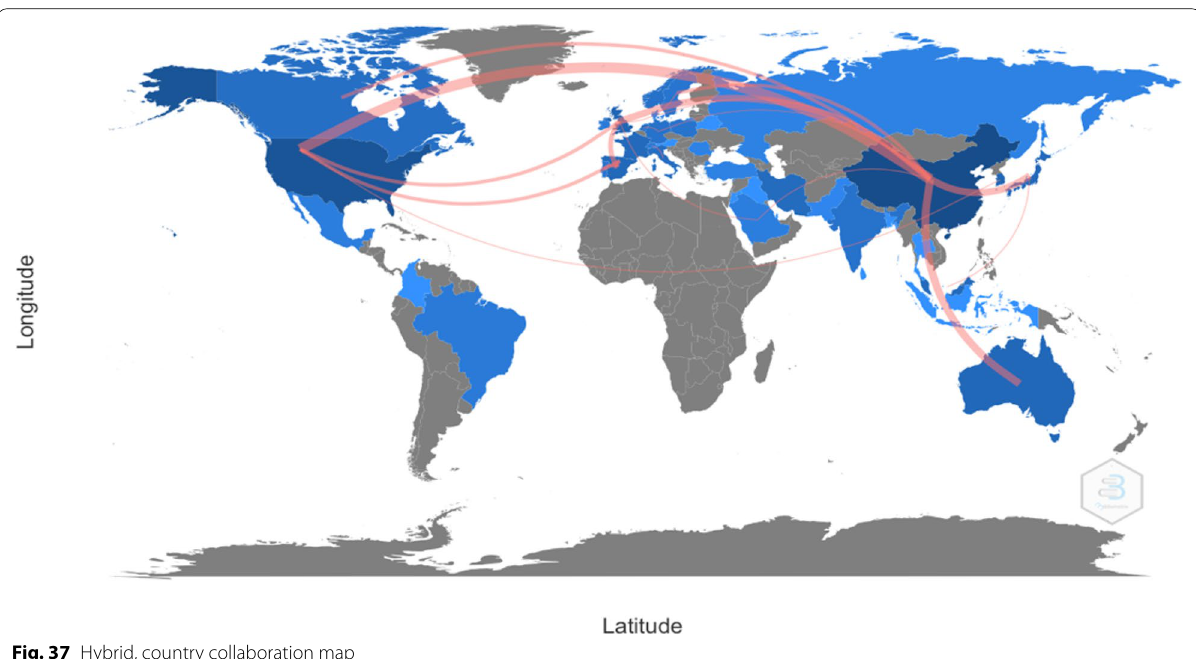
Fig. 37 Hybrid, country collaboration map